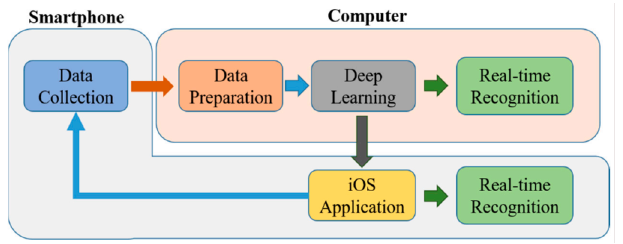
Figure 3. System